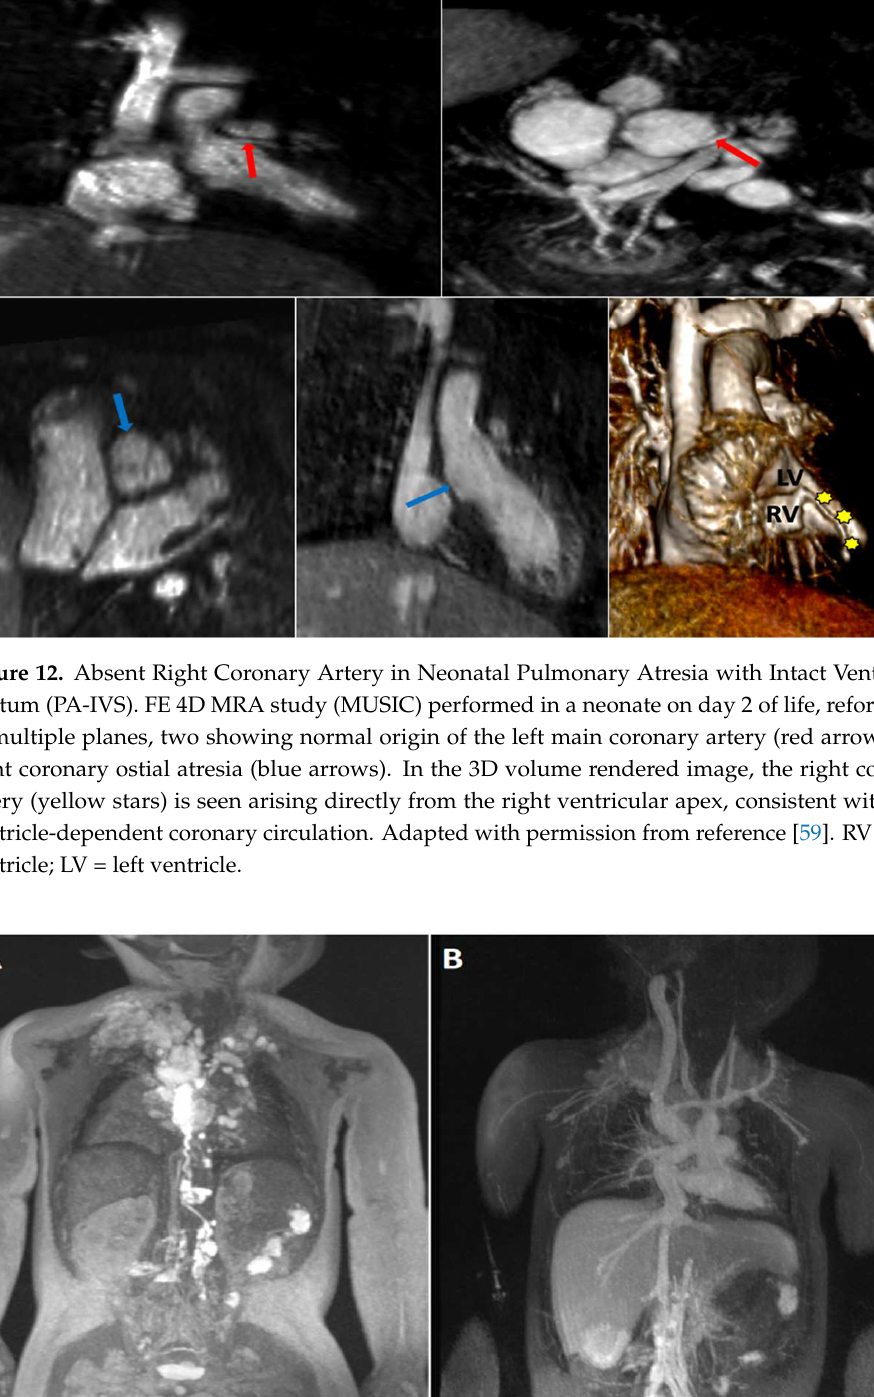
Figure 14. Ferumoxytol-enhanced 4D MRA (MUSIC) with overlayed dynamic contrast-enhanced MR lymphangiogram (DCMRL). Panels ( A – C ): Overlay of the lymphatic (gold), systemic venous (blue), arterial (red), and portal venous anatomy (lavender) arising from a dilated cisterna chylii (black arrow). In this patient with single ventricle anatomy and Fontan circulation, there is complete occlusion of the innominate, left internal jugular, and left brachiocephalic veins (arrowhead). The DCMRL shows a dilated and tortuous thoracic duct (*) with decompressing lymphoceles into the neck secondary to thoracic duct outlet obstruction. Figure courtesy of Dr. Sanjay P. Sinha, Dr. Arash Bedayat, and Takegawa Yoshida. 5. Future Applications CMR/MRA, and ferumoxytol-enhanced CMR/MRA specifically, has an increasingly important role in the care of patients with CHD, potentially obviating the need for cardiac catheterization and/or CTA in certain patients. However, standard CHD imaging proto- cols in children can be complex, require specialized personnel and equipment, and are lengthy to perform [62]. The duration of the exam is especially an issue in the youngest patients who require anesthesia. However, at centers with specialized research agree- ments, ferumoxytol can be used with proprietary research pulse sequences to enable rapid acquisition of high-resolution, cardiac-phase-resolved 3D data with a requirement for only minimal technologist involvement. The addition of self-gating sequences and accel- eration techniques, such as enhanced compressed sensing and artificial intelligence algo- rithms, may allow these examinations to approach the time efficiency of CTA [23,63,64].